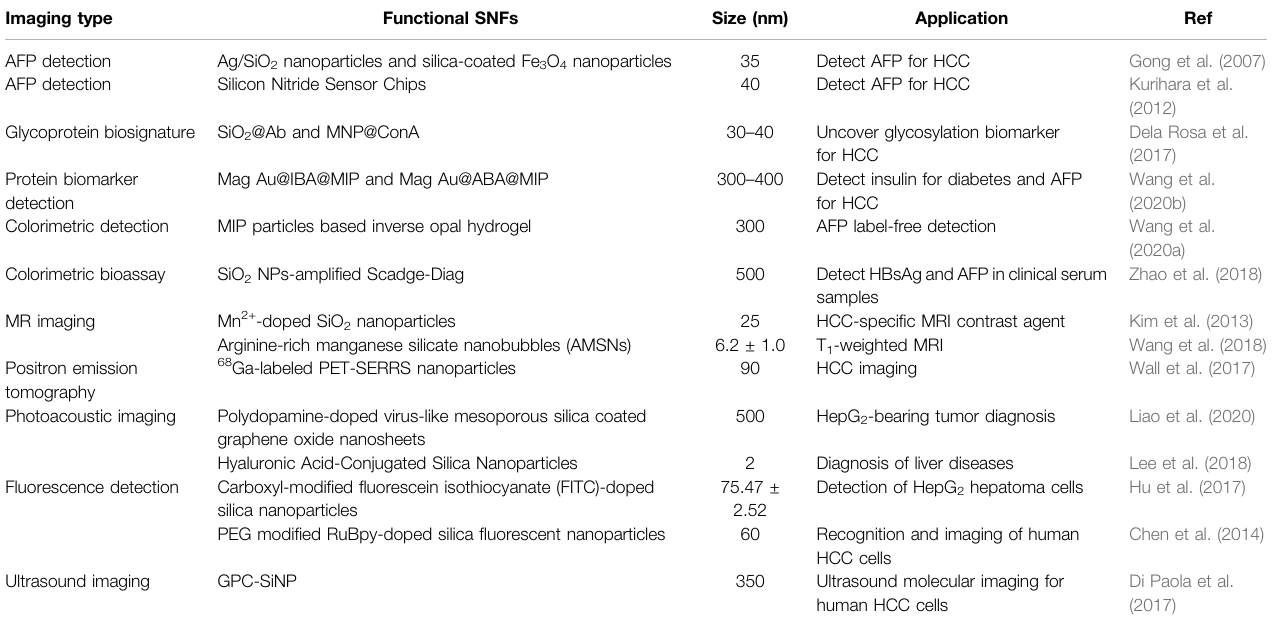
TABLE 1 | The classi fi cation of functional SNFs for HCC